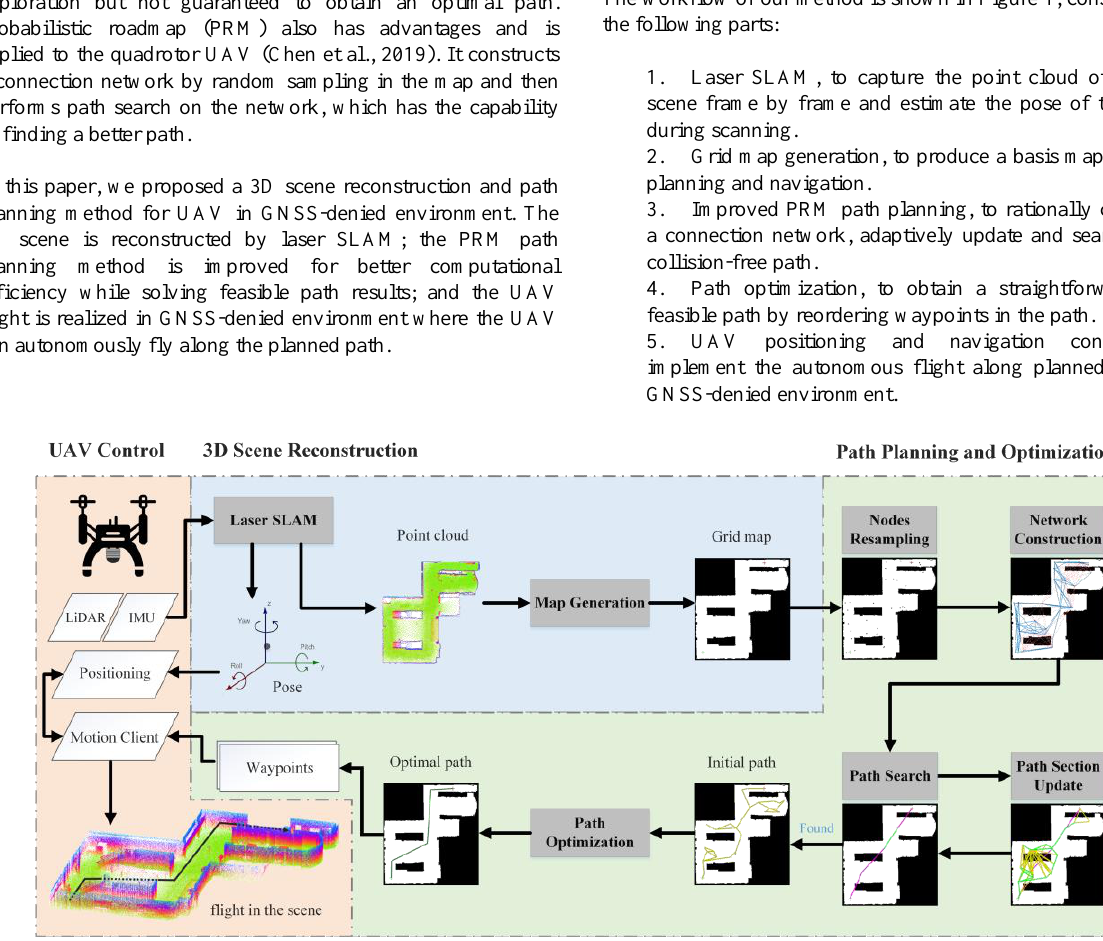
Figure 1 . Workflow of our